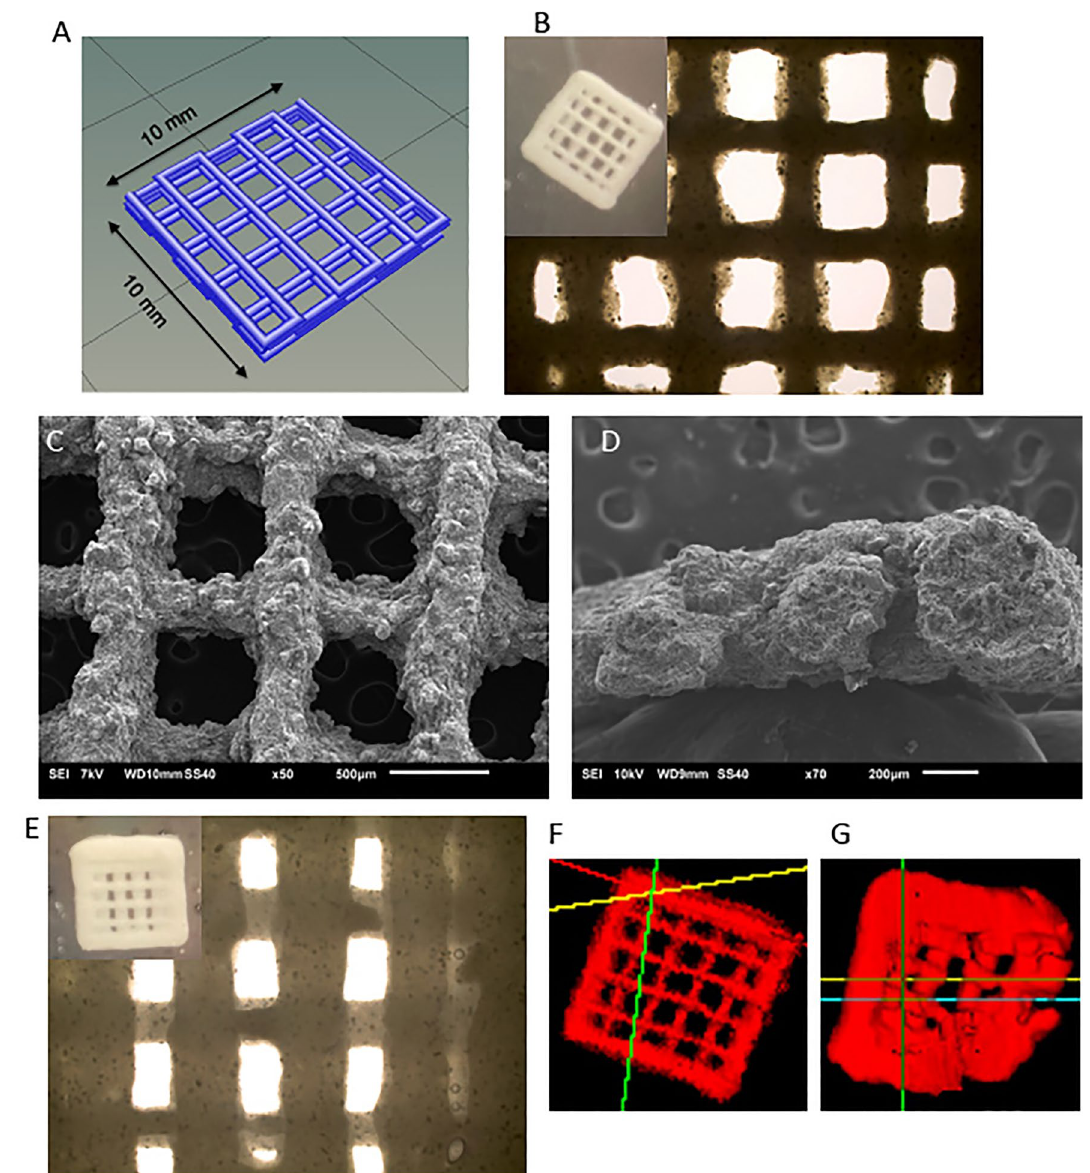
Figure 2. 3D printed constructs for bone regeneration. 3D printed Ink-Bone construct can be designed and printed with or without cells. ( A ) Design of 3D printed construct. ( B )–( D ) Characterization of 3D printed constructs. ( B ) Optical image, ( C ) SEM from top view, and ( D ) SEM from cross-section of 3D printed scaffold without cells. ( E ) Optical image of 3D printed scaffold with cells (9 m/ml). The uCT images of 3D printed constructs ( F ) without cells and ( G ) with 9 m/ml cells and cultured after 27 days. In (A), the scaffold design is 10 mm × 10 mm × 2 mm square. Printed at 10 mm/s. Air pressure is 25kpa for ( B ) and ( F ), and 30kpa for ( C )– ( E ) and ( G ). The original magnifications for ( C ) and ( D ) are ×50 and ×70 BM-MSC group. In the GelXA group, BM-MSCs expressed higher levels of Oc compared to iNCC-MPCs. On was increased in the GelXA group compared to Ink-Bone. In each group, higher levels of On were measured in iNCC-MPCs compared to BM-MSCs (Fig. 3B). µCT analysis in vitro demonstrated no differences in the Bone Volume/Total Volume between the bio-inks. Connectivity density was increased in BM-MSCs and iNCC-MPCs and trabecular number was increased in BM-MSCs in Ink-Bone compared to GelXa (Fig. 3C). In both bio-inks, increased BV/TV was detected in the BM- MSC group versus bio-ink only (Fig. 3C). In the Ink-Bone group, BV/TV levels were increased in the BM-MSC group compared to iNCC-MPCs. In the Ink-Bone group, increased trabecular number values were measured in the BM-MSC group compared to Ink-Bone-only controls (Fig. 3C).